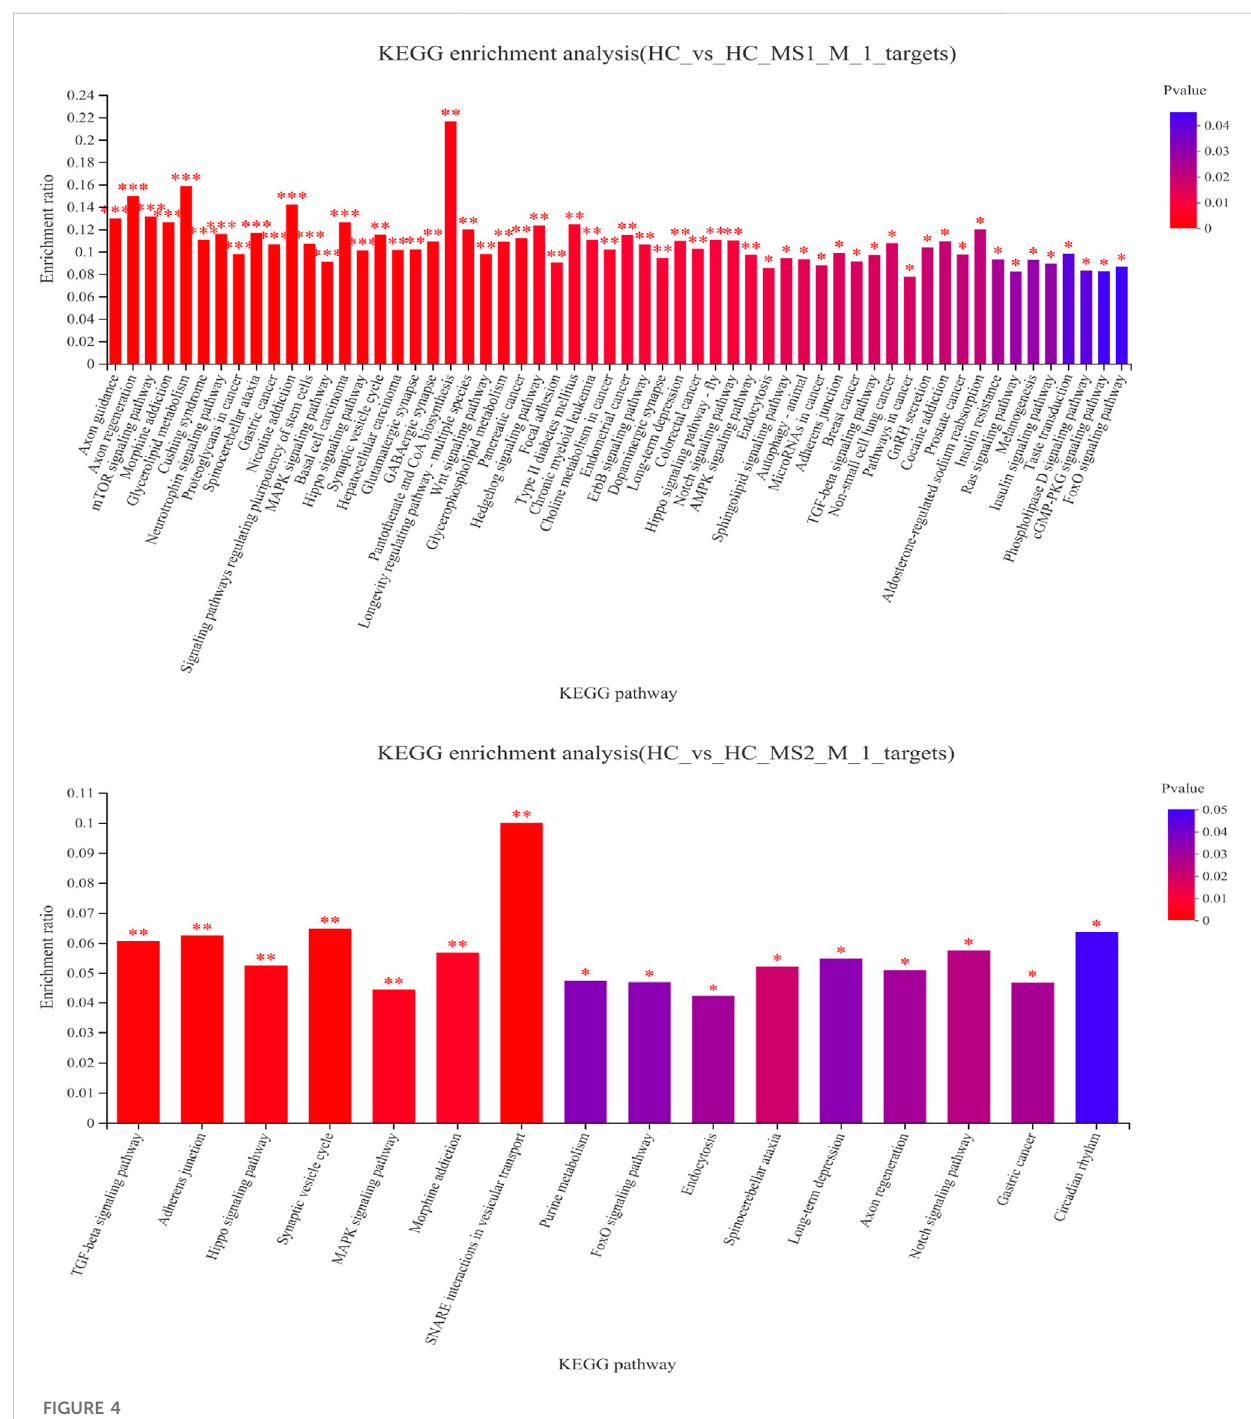
FIGURE 4 KEGG enrichment analysis of differentially expressed candidate target genes of known miRNAs in the liver (n =